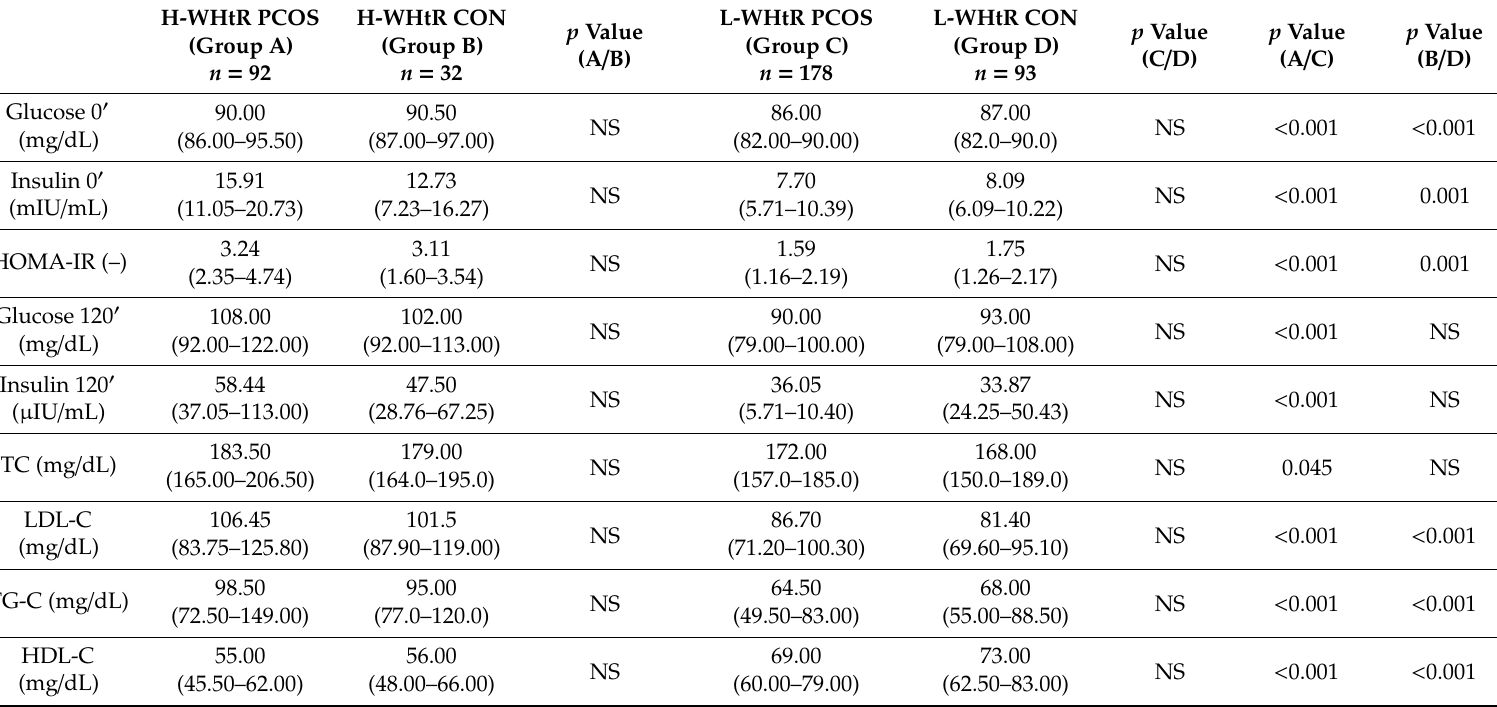
Table 2. Biochemical parameters in the PCOS and CON